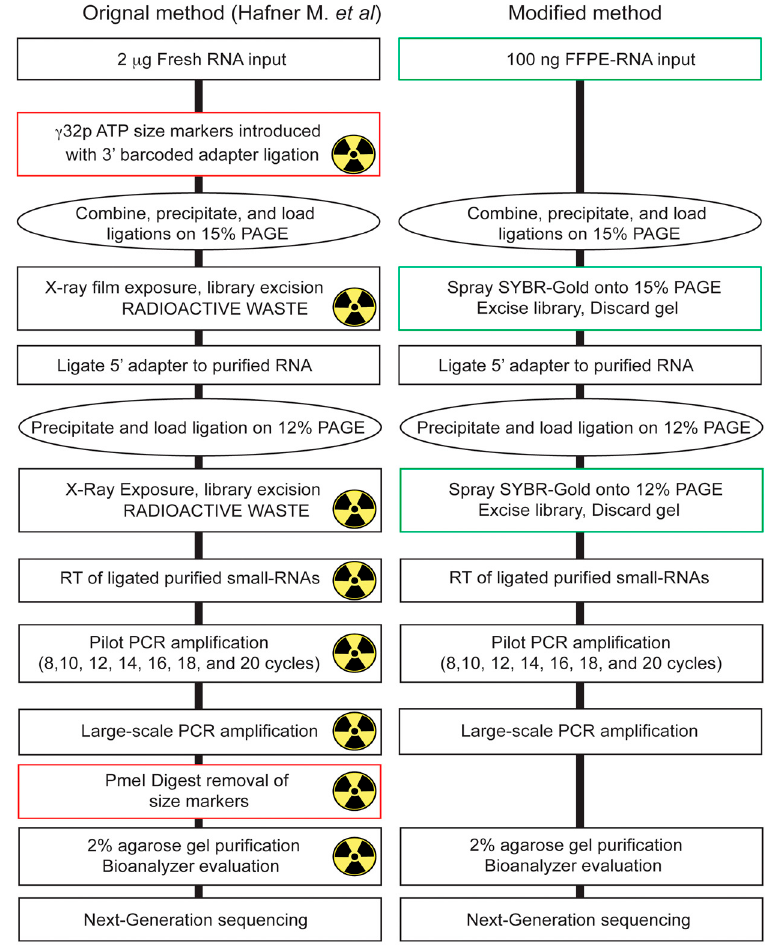
Figure 6. Side by side comparison of the original and modified cDNA library preparation method. Molecular biology steps used for small-RNA cDNA library preparation. The green boxes display changes applied to the original method, whereas red boxes display steps that were removed. The radioactive sign in the original method indicates steps where γ − 32ATP-labeled size markers were present.